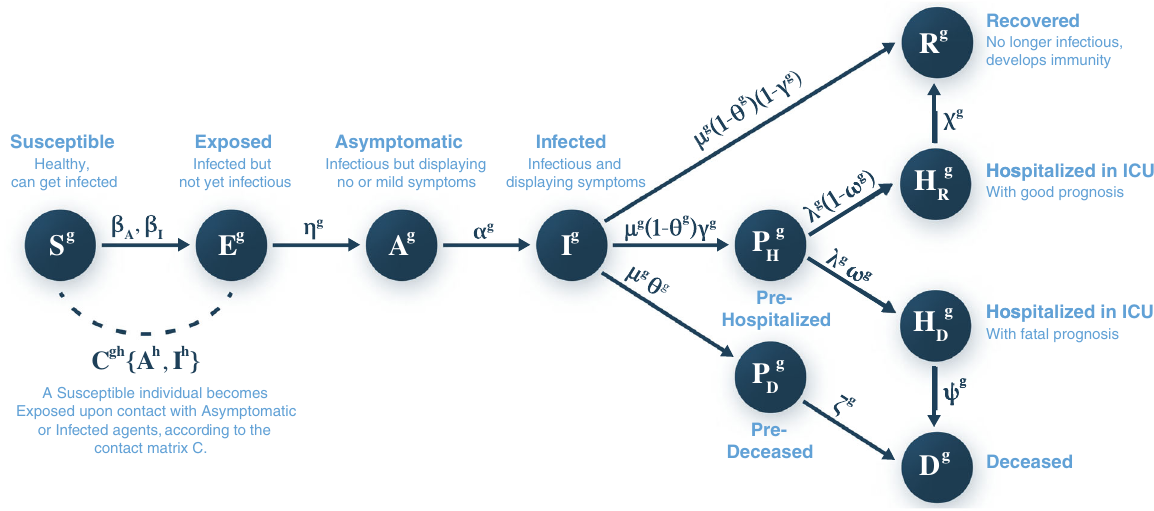
FIG. 1. Compartments of the epidemic model. The acronyms correspond to susceptible ( S g ), exposed ( E g ), asymptomatic infectious ( A g ), symptomatic infectious ( I g ), prehospitalized in ICU ( P g ( H g ), deceased ( D g ), and recovered ( R g ), where g denotes the age stratum of all compartments. The arrows indicate the transition D